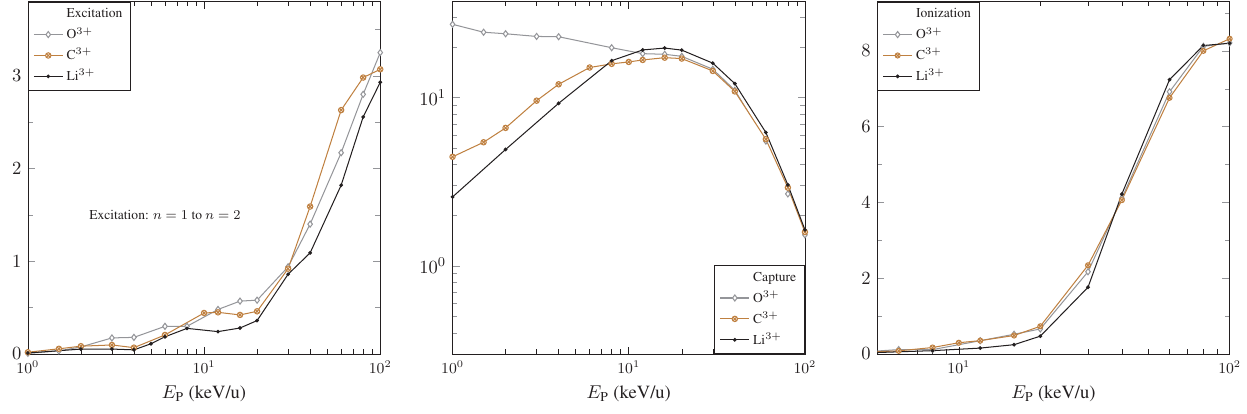
Figure 5. TC-BGM cross sections of Li 3 + -, C 3 + -, and O 3 + -H(1s) collisions plotted with respect to impact energies for target excitation from n = 1 to n = 2 ( left panel ), total electron capture ( middle panel ), and total ionization ( right panel